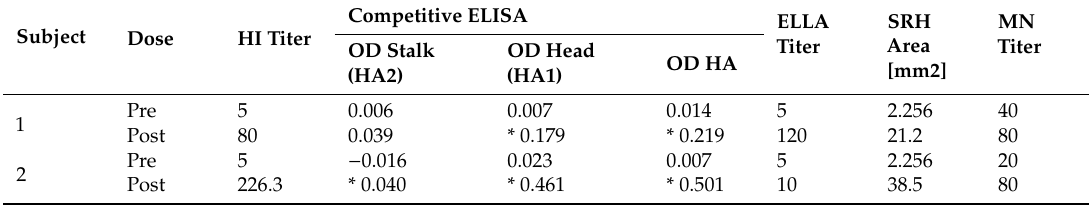
Figure 2. ( A ) Serum samples from adult subjects tested by ELISA, hemagglutination inhibition (HI), single radial hemolysis (SRH), micro-neutralization (MN) and enzyme-linked lectin (ELLA) assays; ( B ) Serum samples from adults tested by ELISA and HI assays. The HI titer of each sample is indicated below the x-axis. Blue bars = head signal, and green bars = stalk signal. Asterisks indicate statistical significance; a black asterisk indicates a significant increase in the HA signal; a blue asterisk indicates a significant increase in the head signal; a green asterisk indicates a significant increase in the stalk signal. Error standard bars are reported both for the head and stalk signals. Table 2. Samples from children tested by the HI, ELISA, ELLA, SRH and MN